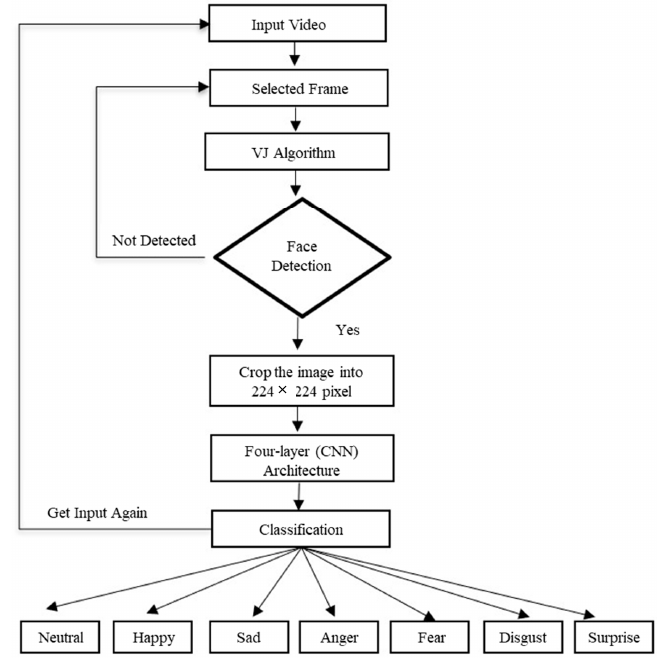
Figure 2. Flowchart diagram of the proposed work.